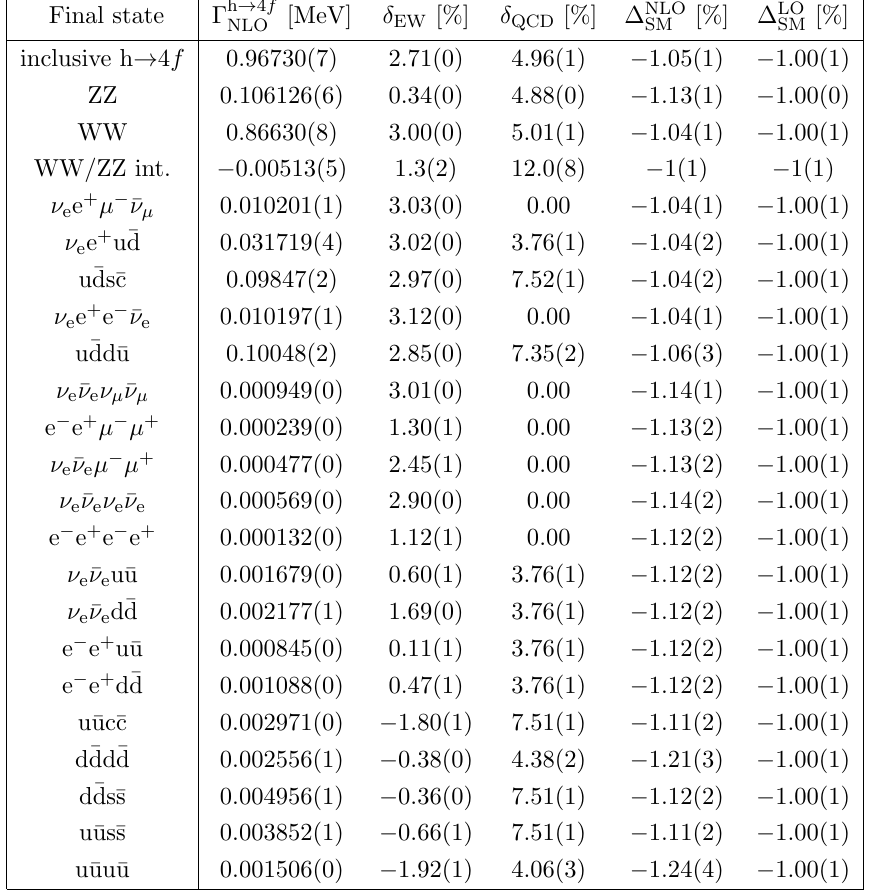
Table 4 . Partial widths for benchmark scenario Aa in the MS( (cid:21) For other schemes, the numbers di(cid:11)er slightly, but show the same qualitative pattern,